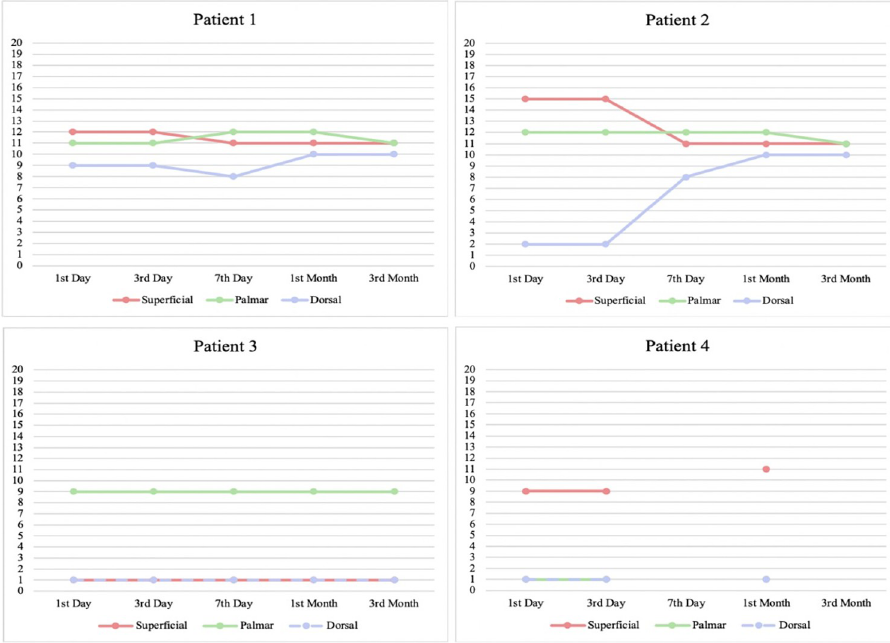
Fig 2. Sensation assessed with 20 Semmes Weinstein monofilament, scored 0–20 from the largest filament (180 g) to the smallest (0,008 g). As seen on the figure, Patient 1 and Patient 2 showed improvement in the dorsal branch, while Patient 4 showed improvement in the superficial branch. There was no improvement for Patient 3.